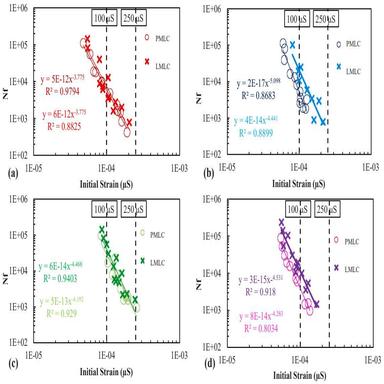
Results of diametral compression fatigue test: (a) CONV; (b) TLAF; (c) HIMA; (d) SBS.